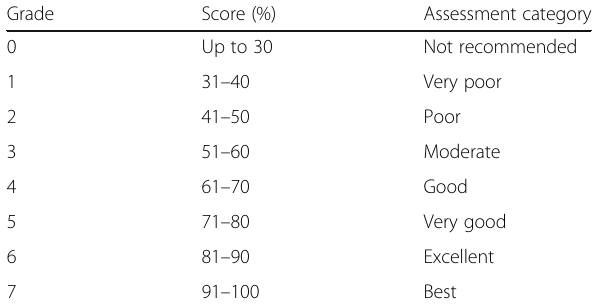
Table 2 Anticipated Performance Index (API) of Tree species Table 1 Tree species gradation based on air pollution tolerance